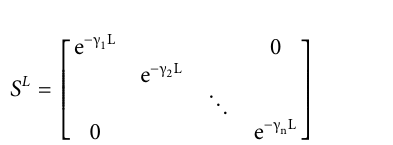
abrupt surfaces 1 and 2, respectively. S represents the scattering and 3 represent the scattering parameters at the left and right ends of the uniform waveguide B, respectively. The superscripts A and C represent the scattering parameters on the left side of the mutation surface 1 and the right side of the mutation surface 2, respectively, and S L represents the transmission matrix between the mutation surfaces 1 and 2, the de fi nition of S L is as Eq. 1